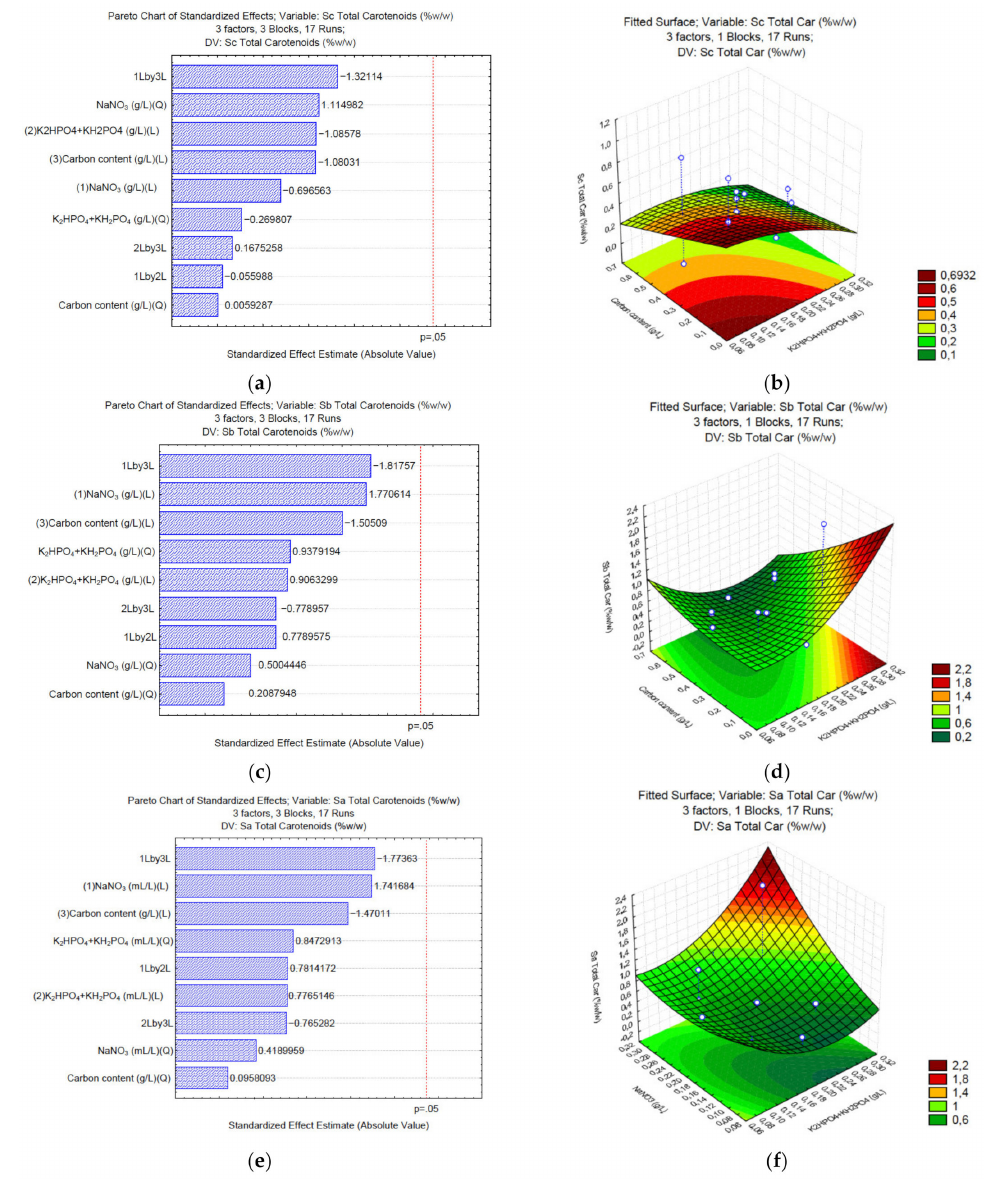
Figure 4. Pareto charts and surface response of total carotenoids production using Na 2 CO 3 ( a , b ), NaHCO 3 ( c , d ), and C 2 H 3 NaO 2 ( e , f